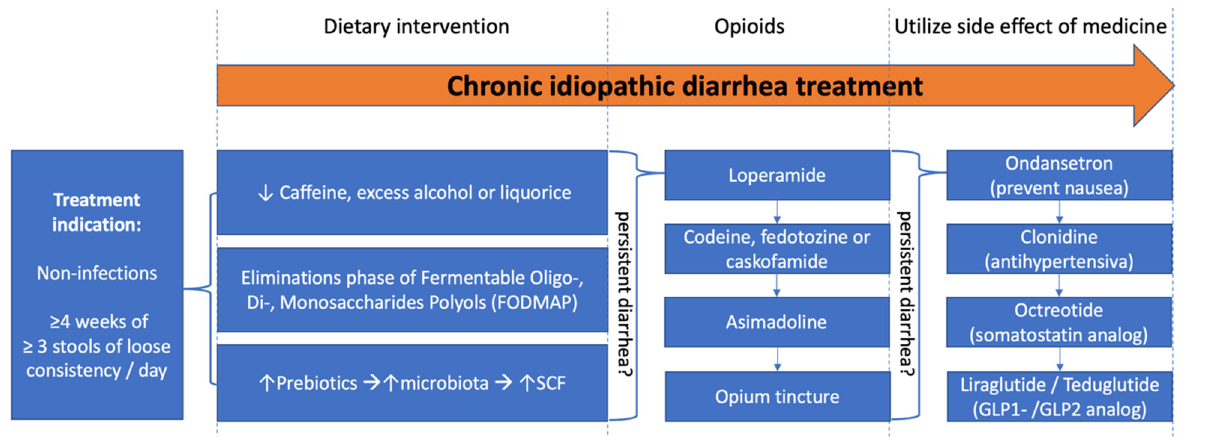
Figure 2. Clinical treatment algorithm used to select treatment level for patients with chronic idiopathic diarrhea.